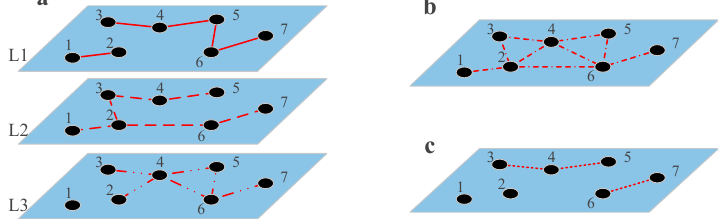
Figure 1. Multiplex networks model: ( a ) Multi-layers, ( b ) aggregation layer, and ( c ) overlap layer.